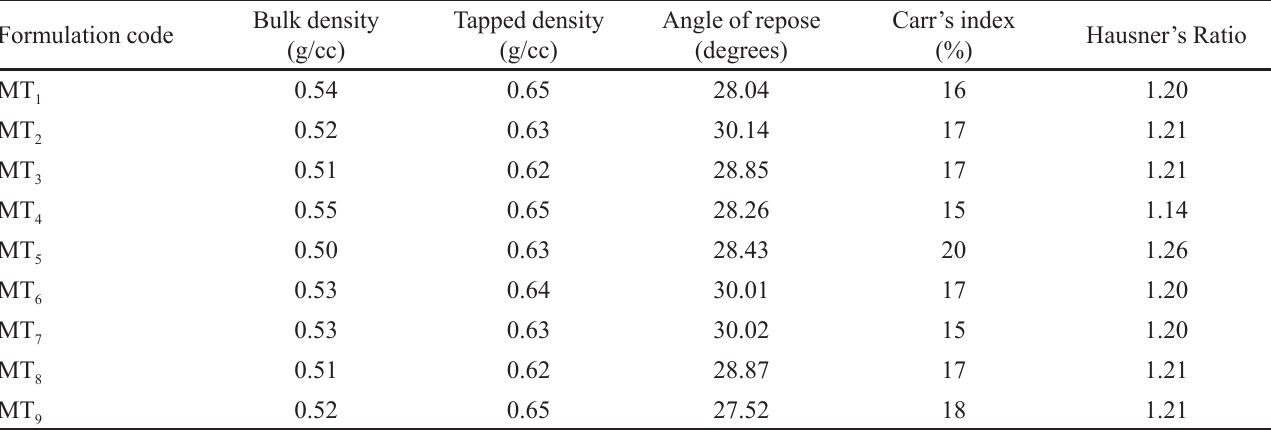
TABLE IV - Pre-compression results of direct compression method Formulation code